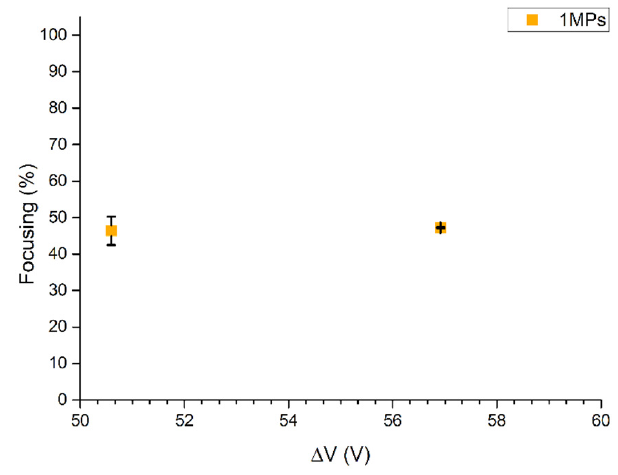
Figure 7. UV–Vis characterization of focusing performance of the BAW device with 1MPs concen- trated at 1.00 × 10 6 particles/mL injected at 1 µ L/min when the device was actuated at its resonance frequency of 4.623 MHz. Experiments were performed by applying 50.59 Vpp and 56.92 Vpp at the transducer.